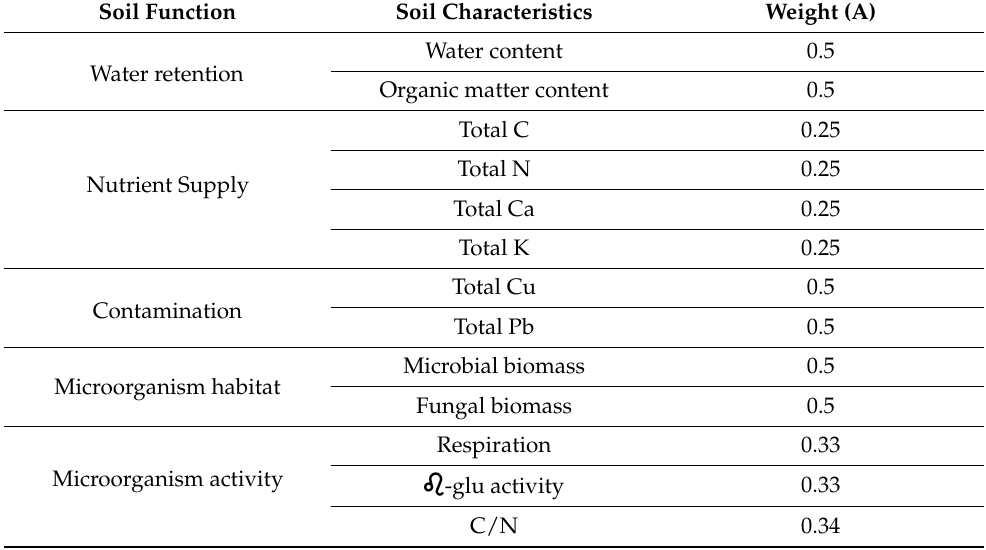
Table 1. Weights assigned to each investigated soil characteristic grouped in the five considered soil